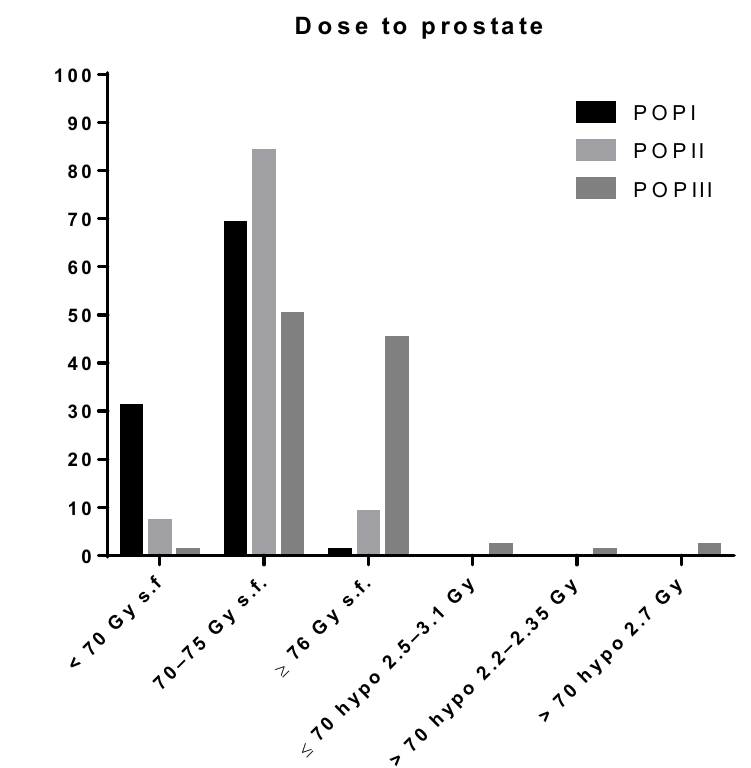
Figure 1. Dose delivered to prostate: POP I (1995–1998), POP II (1999–2003), POP III (2004–2011). Hypo: hypofractionation, s.f.: standard fractionation.